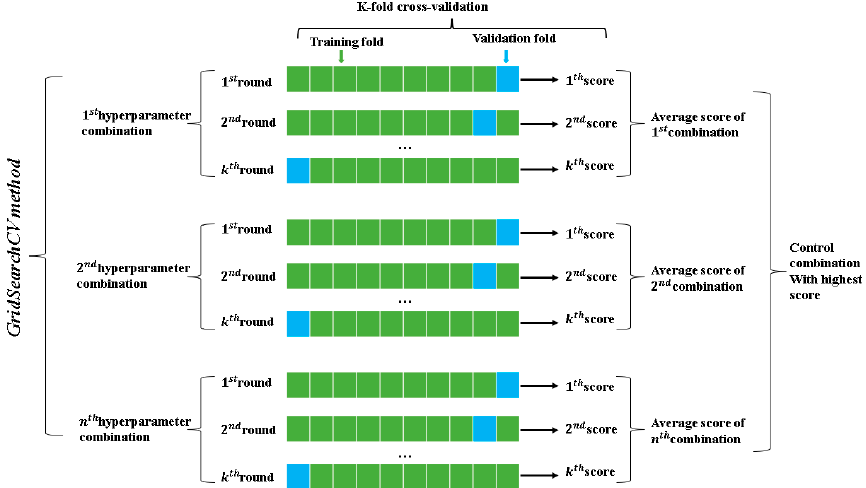
Figure 1. Schematic diagram of grid parameter optimization algorithm.